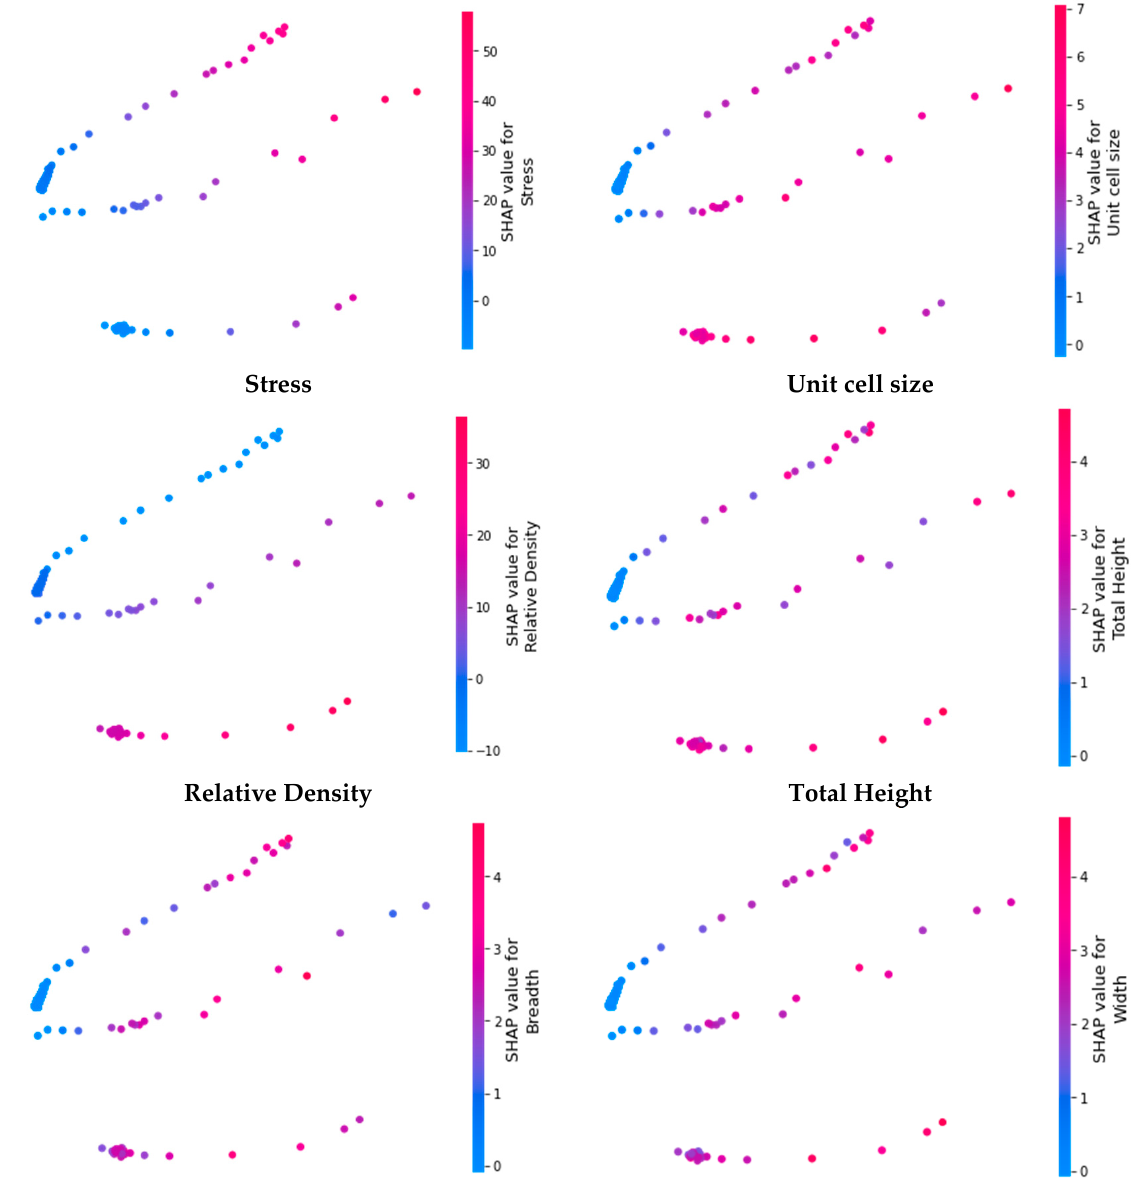
Figure 12. Embedding plots to interpret the predictions of the DL model.